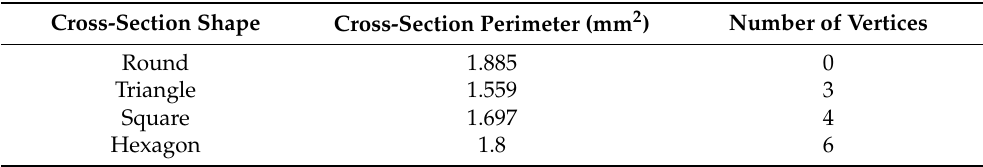
Table 2. Contact perimeter and number of vertexes for MNAs with different cross-section shapes. Cross-Section